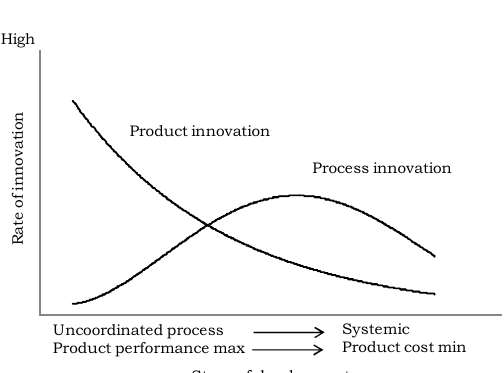
Figure 1. A-U model in Utterback and Abernathy (1975) From “A dynamic model of process and product innovation,” by J. M. Utterback and W. J. Abernathy, 1975, Omega , 3 (6), p. 645, Figure 1. Copyright 1975. Reprinted by permission of Elsevier.